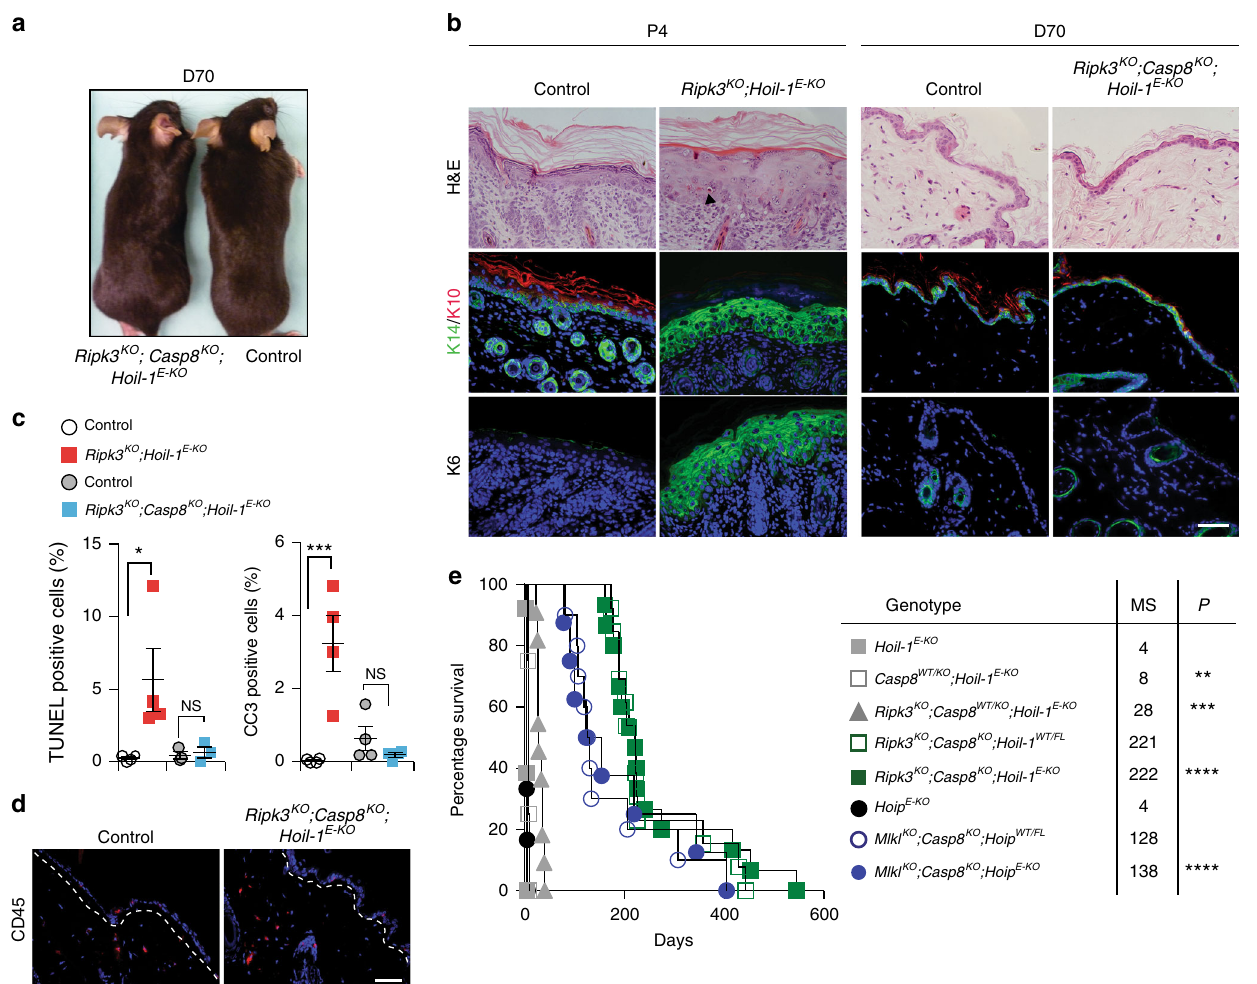
Fig. 6 Aberrant apoptosis drives lethal dermatitis in Hoip E-KO and Hoil-1 E-KO mice. a Representative images of mice of the indicated genotypes, ( n = 15